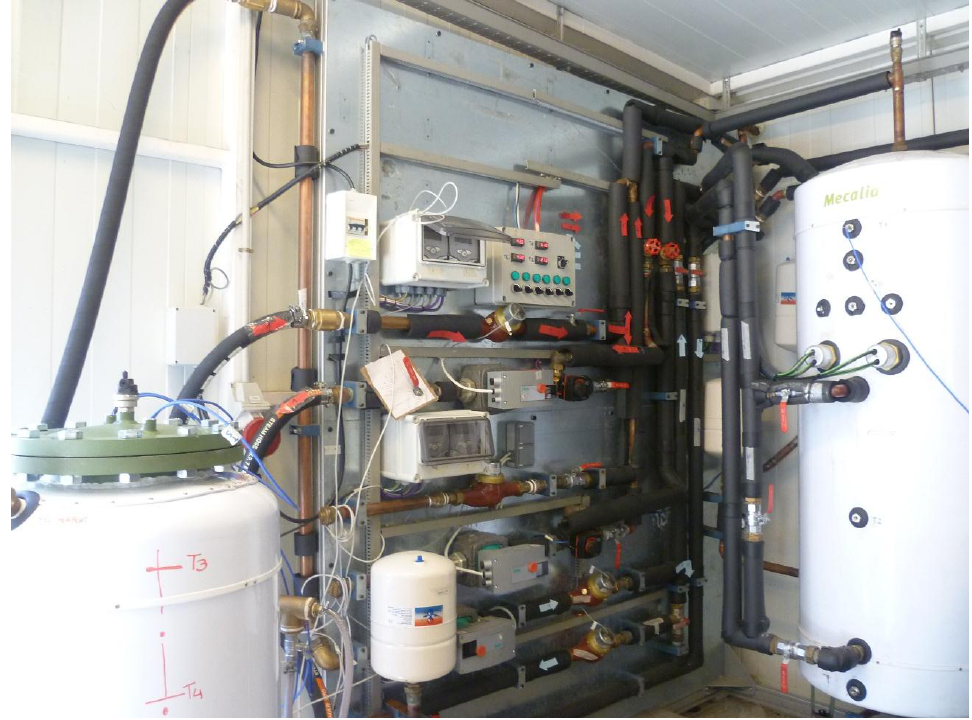
Figure 2. Photograph of the experimental facility.